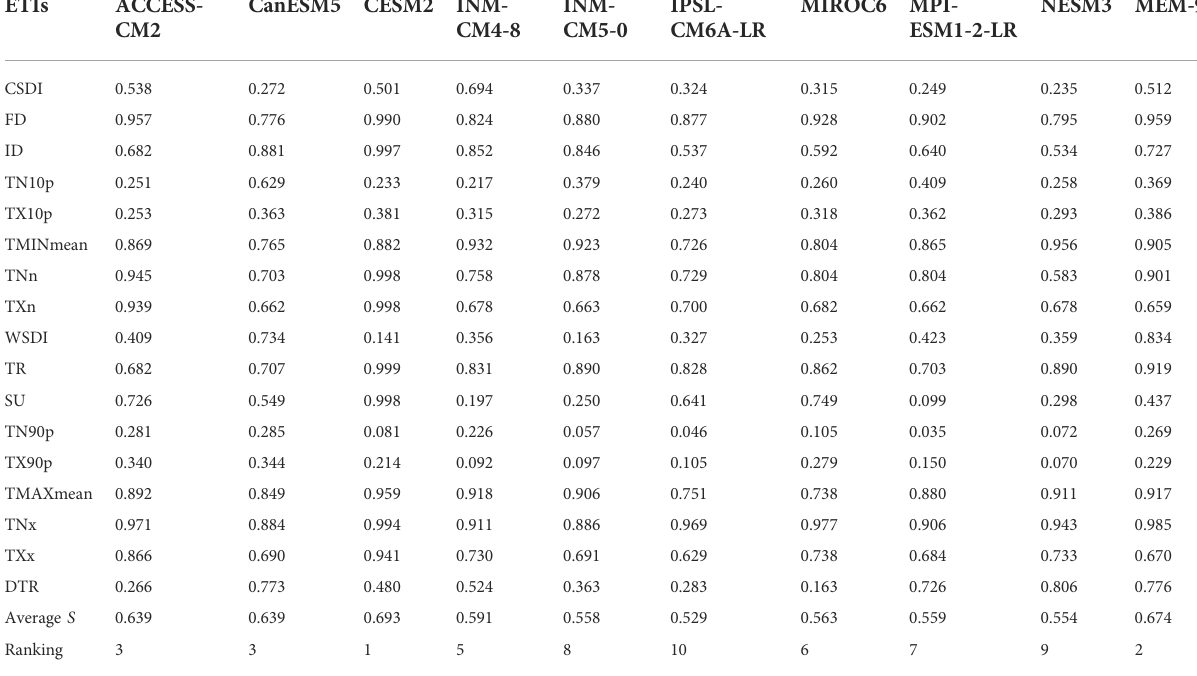
TABLE 4 Skill scores ( Ss ) between simulated and observed ETIs for nine single models and MEM-9.